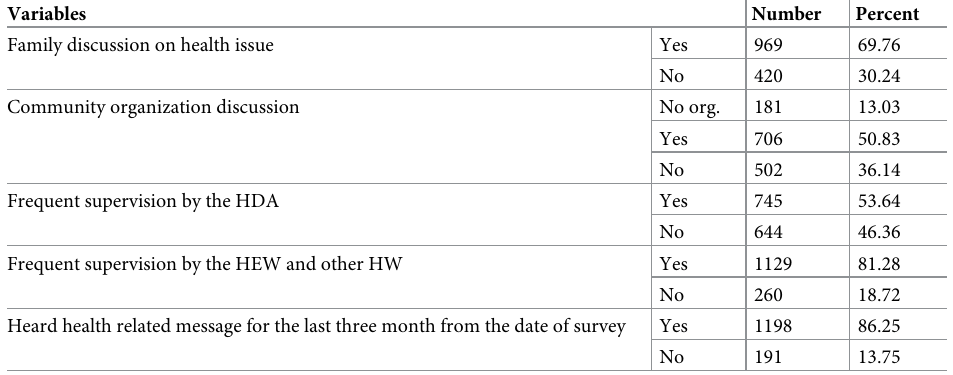
Table 2. Health information and supervision system in Wogera and East Dembiya District, North west Ethiopia, December